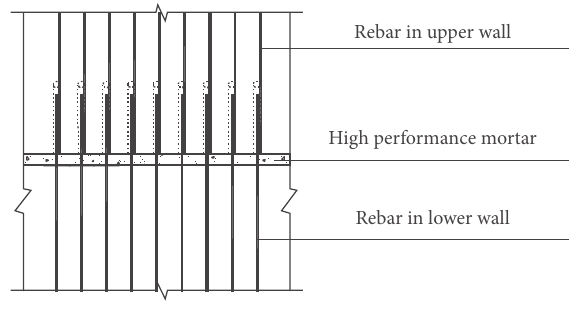
Figure 3: Conventional